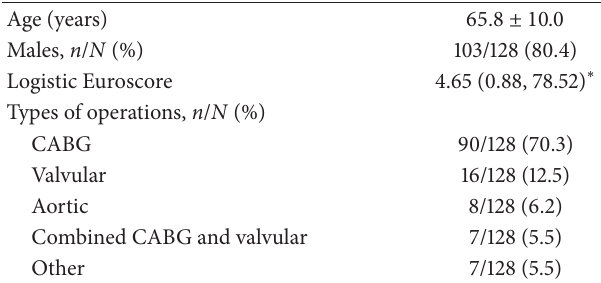
Median (range). CABG: coronary artery bypass